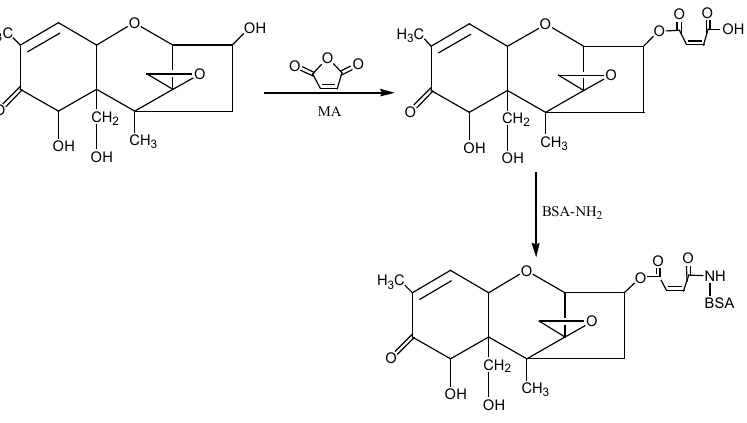
Figure 8. The synthesis route of DON - BSA by the EDC method. Isobutyl chloroformate (IBCF) method: According to the molecular structure of DON, the hydroxyl groups ( − OH) at the 7th and 15th positions of DON were first blocked with 1-butylboronic acid, and then the hydroxyl group at the 3rd position of DON was reacted with succinic anhydride (SA) to introduce the active group ( − COOH) to form the semiester compound DON-HS. Under the action of IBCF, the artificial antigen DON-BSA was synthesised by coupling of the carrier protein BSA with NH 2 in the form of a monoamide bond ( − CONH − ). The preparation process of this method was improved according to the IBCF method described by Casale et al. [25] and Li et al. [26]. The detection antigen DON- OVA was prepared by the same method. The synthesis route is shown in Figure 9 .